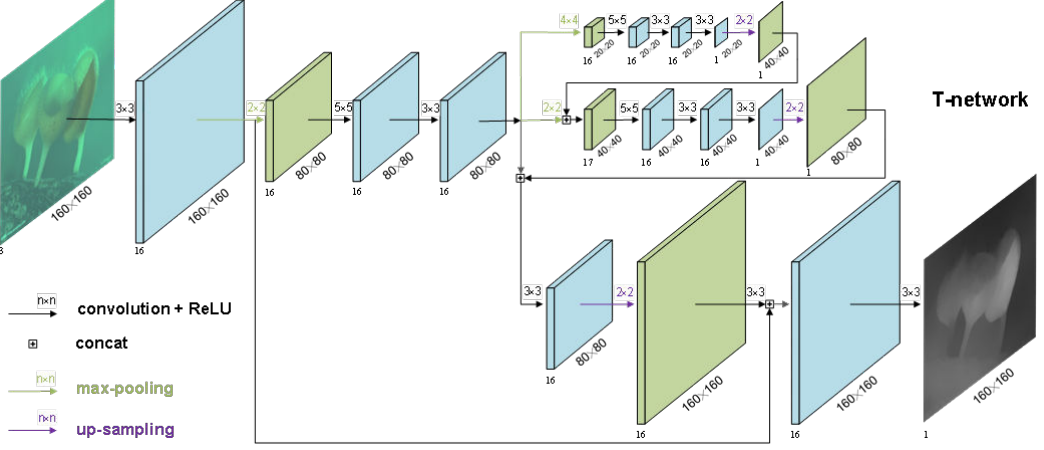
Figure 5. The architecture of